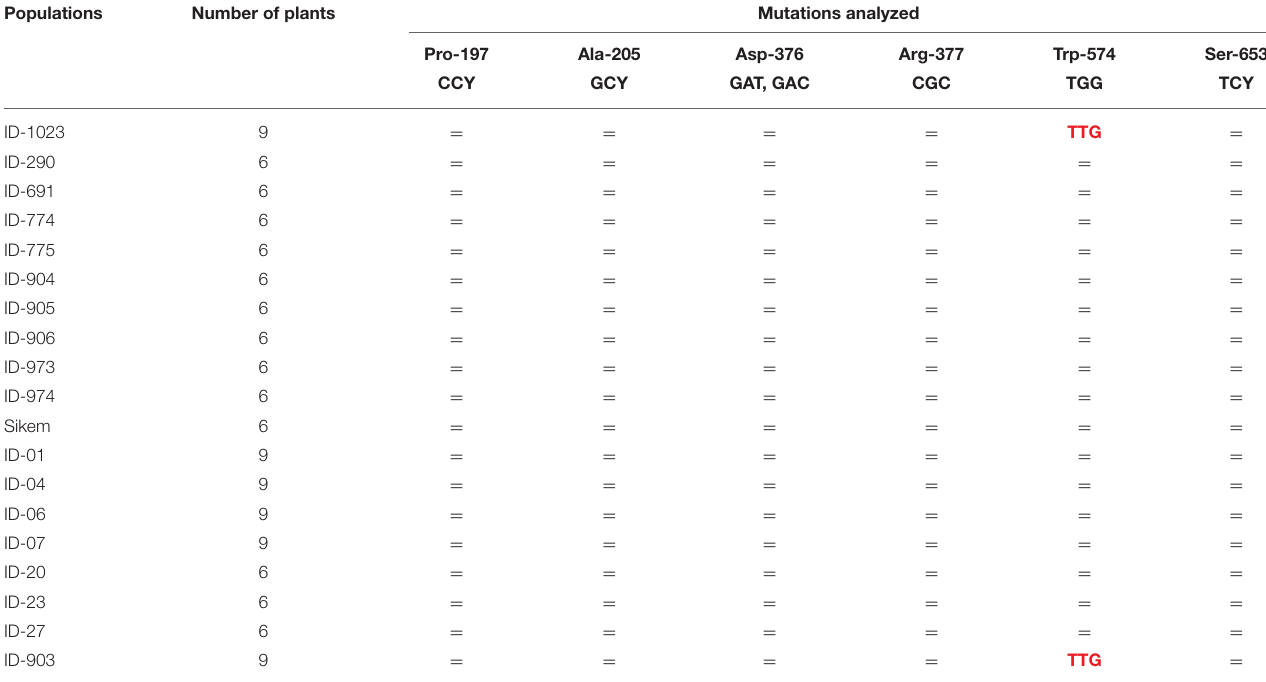
Letter shown in red and bold are identified mutations, and represent amino acids, TTG = Leucine.